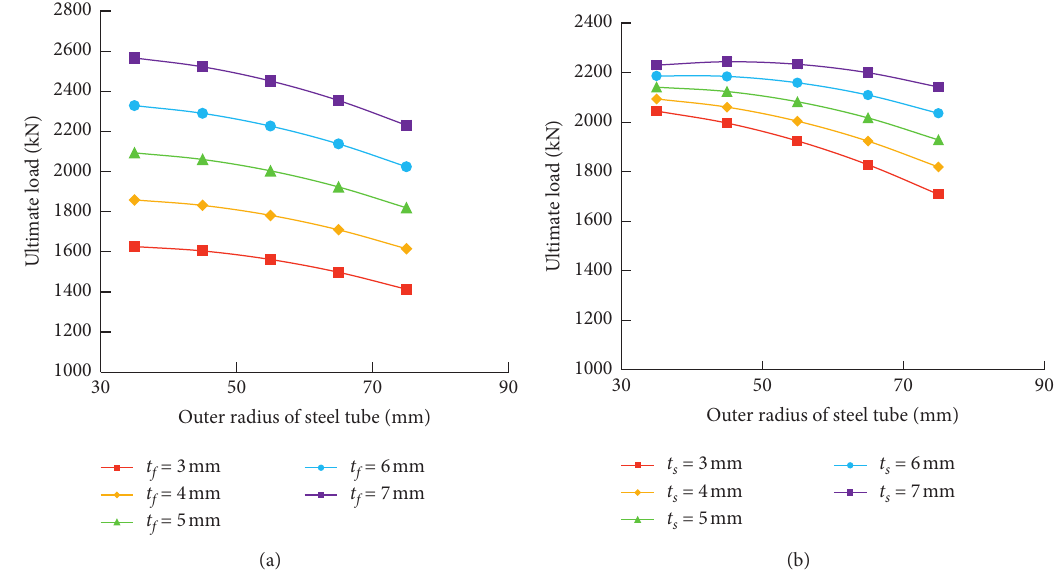
Figure 14: Influence of outer radius of the steel tube on ultimate